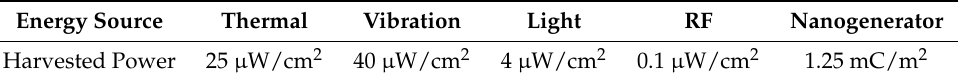
Figure 1. Block diagram of a complete energy harvesting system. Table 1. Comparison of harvested power from different energy